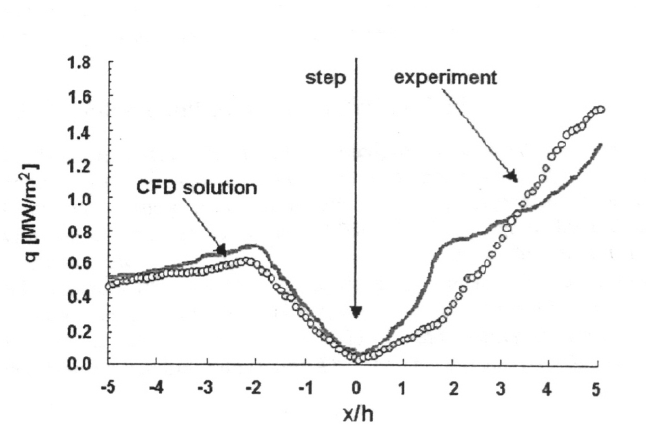
Figure 65. Heat flux comparisons along the centreline of the fuel injector side